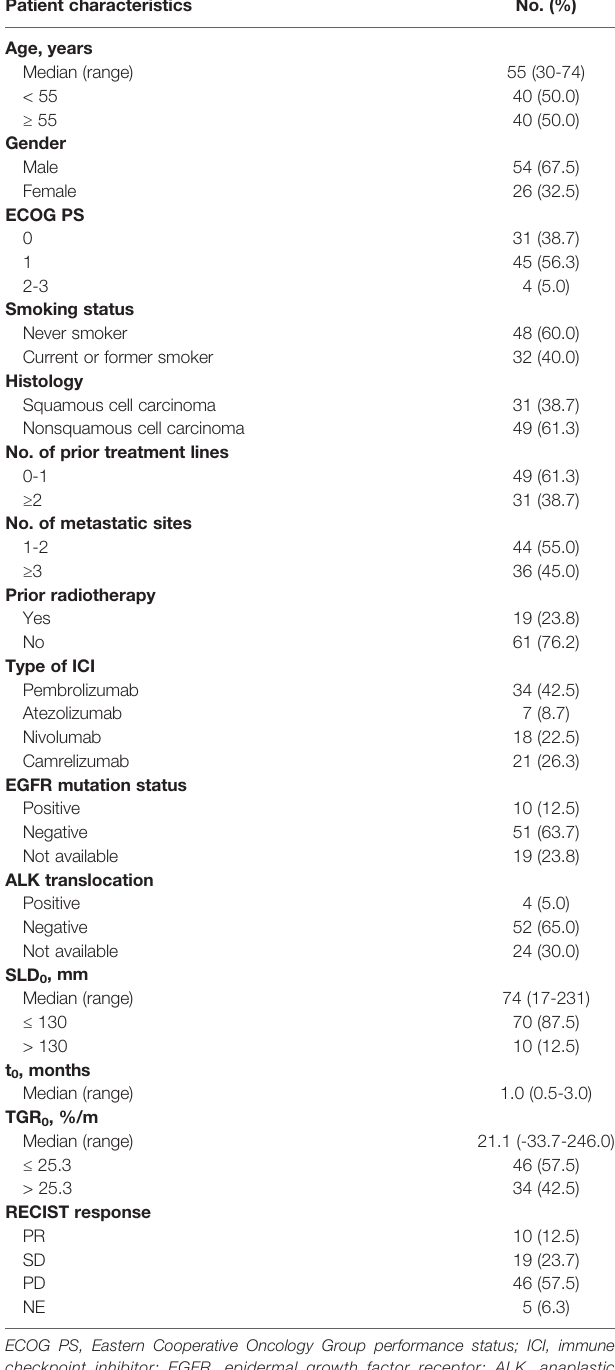
TABLE 1 | Patient characteristics at baseline (n =